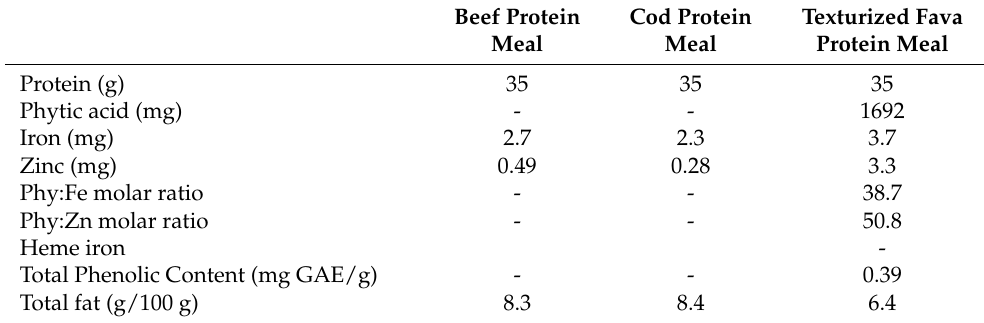
Table 2. Composition of test